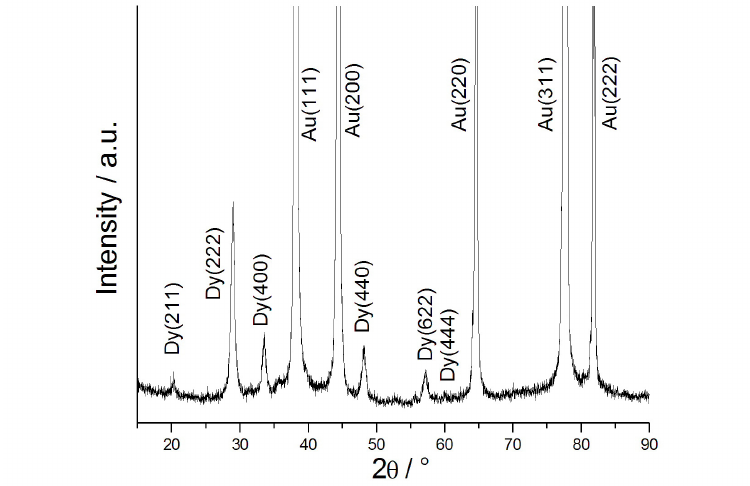
Figure 3. X-ray diffractogram of Au-Dy − 1.8 V for 2 hour, after heat treatment at 650 °C for 1 hour.